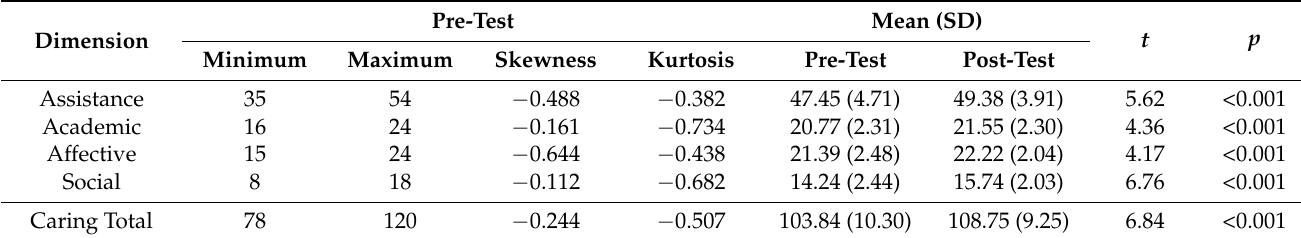
Table 1. The modified PCM scores report at pre-test and post-test.